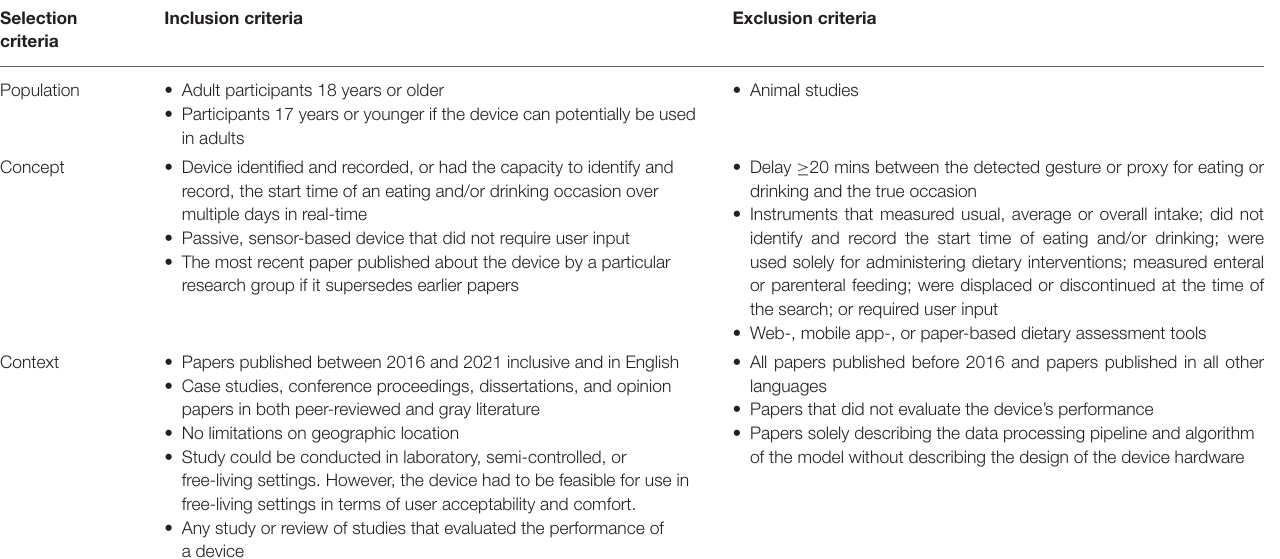
TABLE 1 | Inclusion and exclusion criteria of the scoping